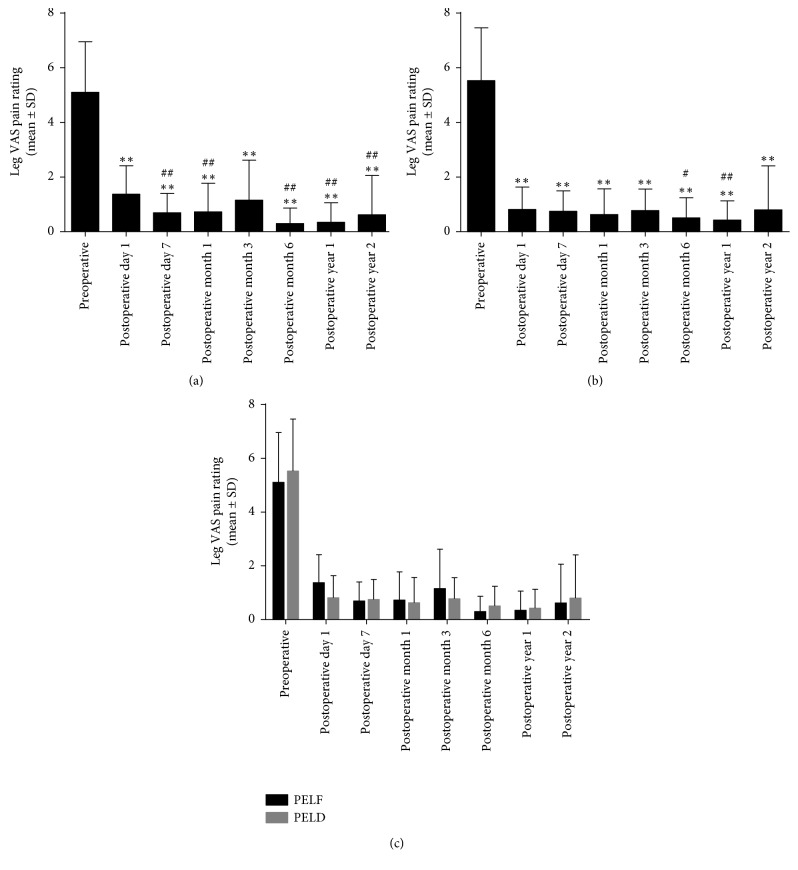
Leg VAS pain rating before and after TF PELF and PELD. (a and b) Leg VAS pain rating decreased significantly at postoperative all time points compared with that preoperatively in both PELF and PELD groups (P < 0.01). Compared with postoperative day 1, VAS score decreased at postoperative day 7, month 1, month 6, year 1, and year 2 in the PELF group (P < 0.01), and at postoperative month 6 (P < 0.05) and year 1 (P < 0.01) in the PELD group. (c) No significance between the 2 groups (P > 0.05). ∗∗P < 0.01, compared with that preoperatively; #P < 0.05, ##P < 0.01, compared with postoperative day 1.